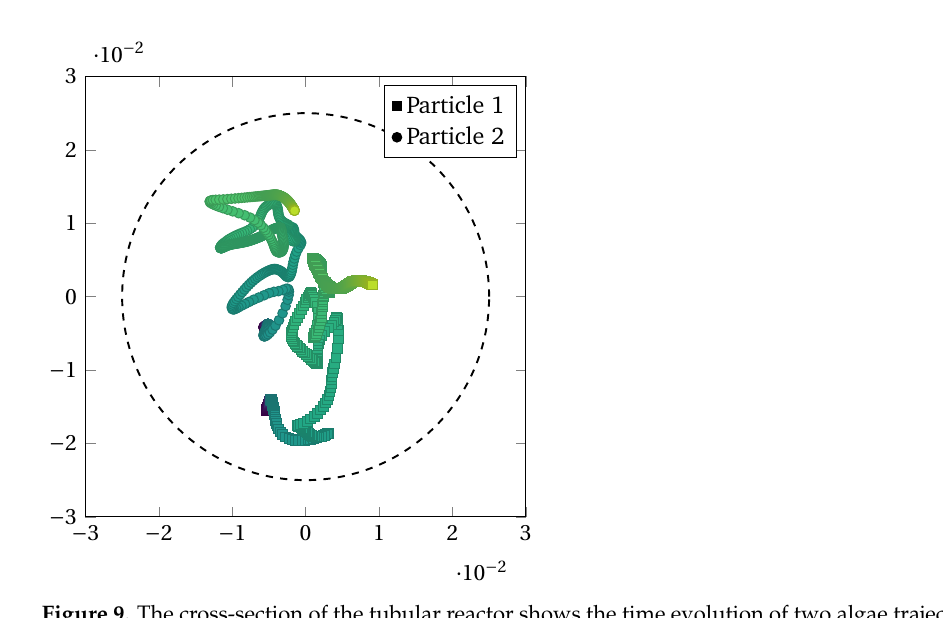
Figure 9. The cross-section of the tubular reactor shows the time evolution of two algae trajectories in the xy -plane. The trajectory starts are indicated by dark blue and the ends by light green, respectively.